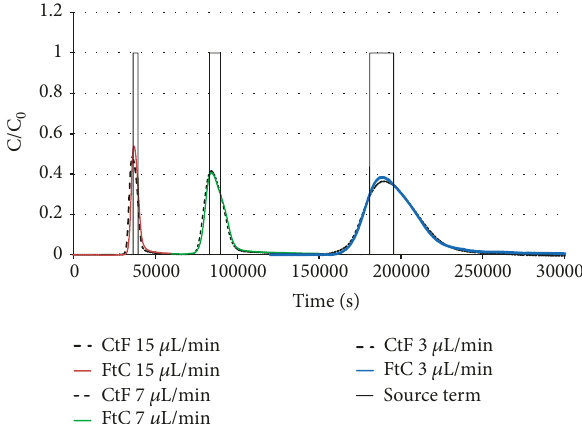
Figure 5: Breakthrough curves for the CtF and FtC experiments with column #2 (F and CC bead sets), for an injection of 2.7 mL of 0.1M solution of sodium nitrate.